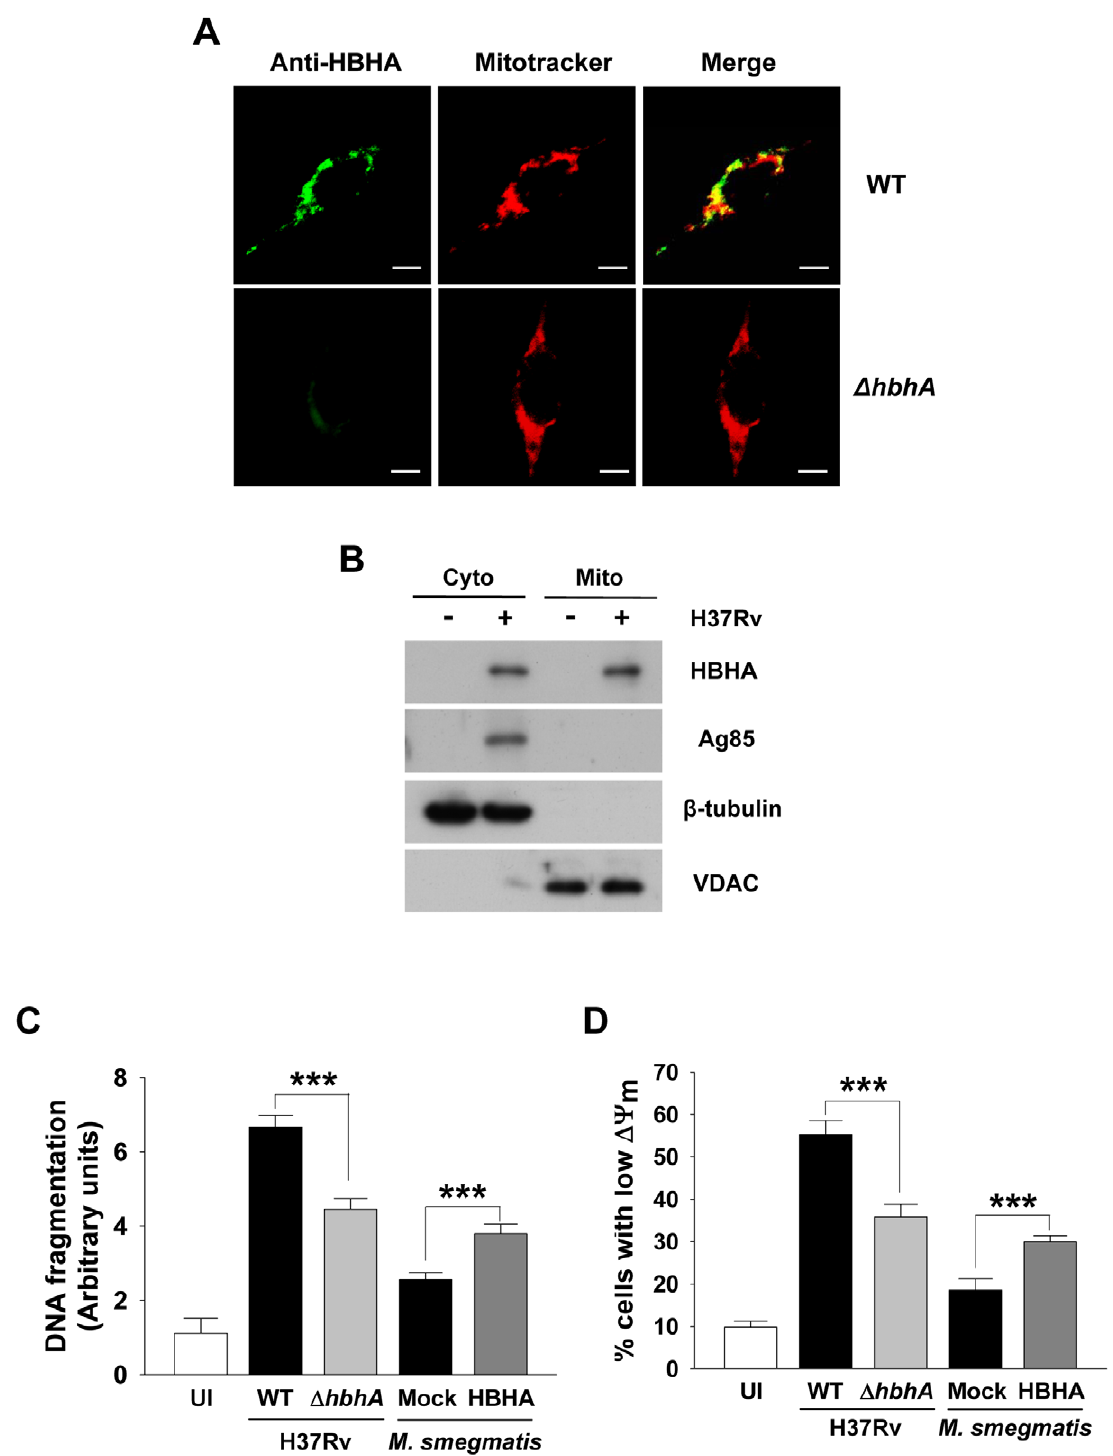
Figure 7. Disruption of hbhA decreases apoptosis and DY m dissipation in macrophages infected with M.tuberculosis . ( A ) RAW 264.7 cells were infected with M. tuberculosis 103 wild-type (WT) and mutant ( D hbhA ) at a multiplicity of infection (MOI) of 1 for 12 h. Cells were double stained with Mitotracker and HBHA-specific antiserum followed by an Alexa 488-conjugated secondary antibody. Scale bar, 5 m m. ( B ) BMDMs were infected with M. tuberculosis at an MOI of 1 for 12 h. Mitochondrial and cytosolic fractions were separated from cell lysates and examined by Western blot using specific antibodies against HBHA, Ag85, VDAC, and b -tubulin. ( C,D ) BMDMs were infected with M. tuberculosis wild-type (WT) and mutant ( D hbhA ) or M. smegmatis ectopically expressing HBHA (HBHA) or empty plasmid (Mock) at an MOI of 5 for 24 h. DNA fragmentation (C) and DY m (D) were measured as described in Figure 1 and 2, respectively. Data are the mean 6 SD from six separate experiments. *** P , 0.001 cells infected with M. tuberculosis WT versus with mutant strain and cells infected with M. smegmatis expressing HBHA versus with Mock transformant.